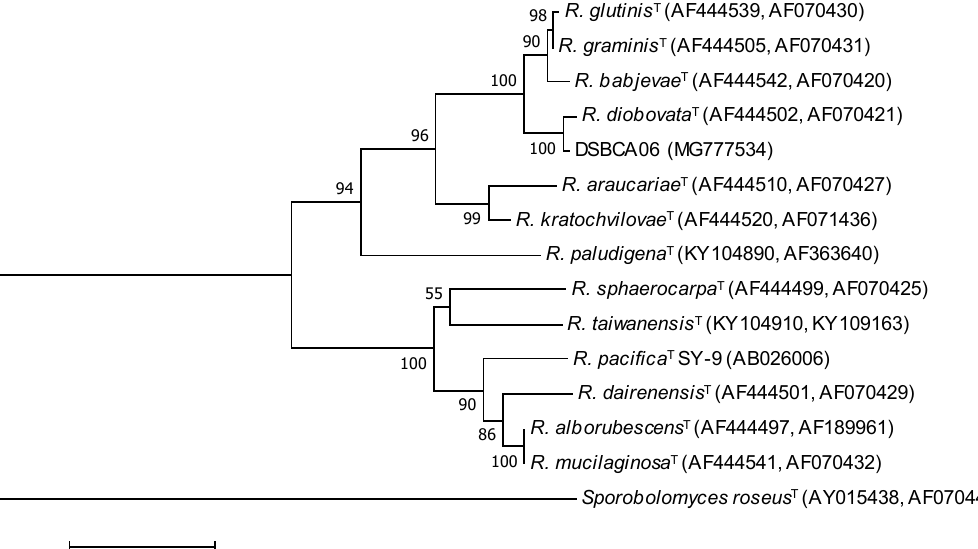
Figure 1. Unrooted phylogenetic tree based on the comparisons of the internal transcribed spacer (ITS) regions and D1/D2 variable domains of the large subunit (LSU) rRNA gene showing the position of the strain DSBCA06 (characterized in this work) and the type strains of selected related species. The tree was constructed with a total of 1146 positions, using a neighbor-joining distance matrix. The scale bar indicates substitutions per nucleotide position. The Bootstrap values are indicated at the nodes. The GenBank accession numbers are reported in brackets.